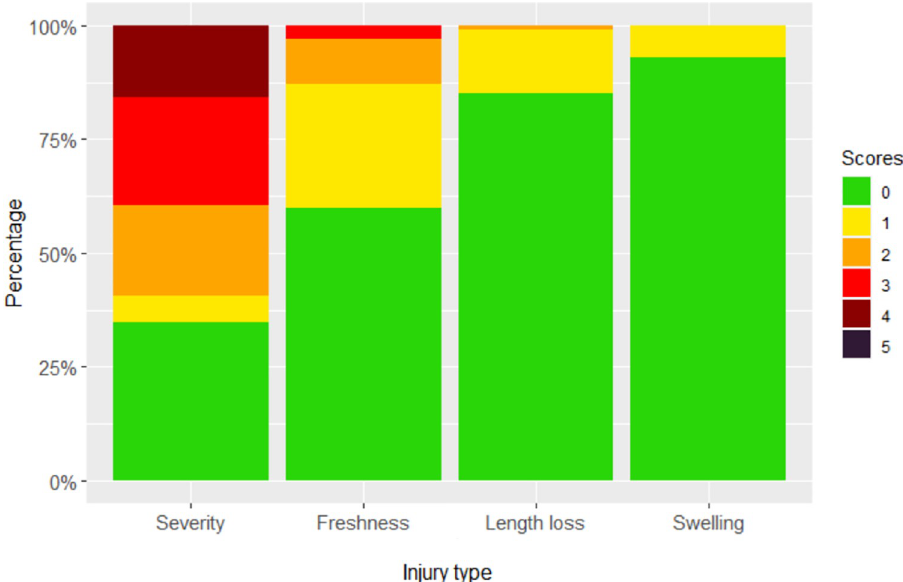
Fig 1. Stacked bar graphs of frequency of tail injury scores. Tails were scored on severity (0, 34.9%; 1, 5.6%, 2, 19.6%; 3, 23.6%; 4, 16.4%), freshness (0, 59.8%; 1, 27.1%; 2, 9.8%; 3, 3%; 4, 0.3%; 5, 0.1%), length loss (0, 85.4%; 1, 13.5%; 2, 0.8%; 3, 0.3%), and presence of swelling (0, 93.2%; 1, 6.8%) (See S1 File for score descriptions).